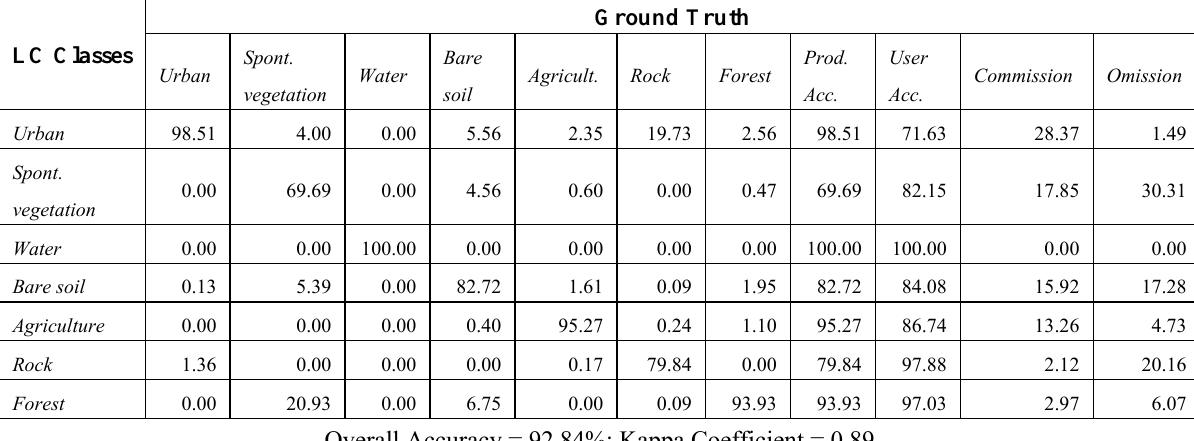
Table 3. Results (Percentages) from the accuracy assessment process (ASTER 2007). LC